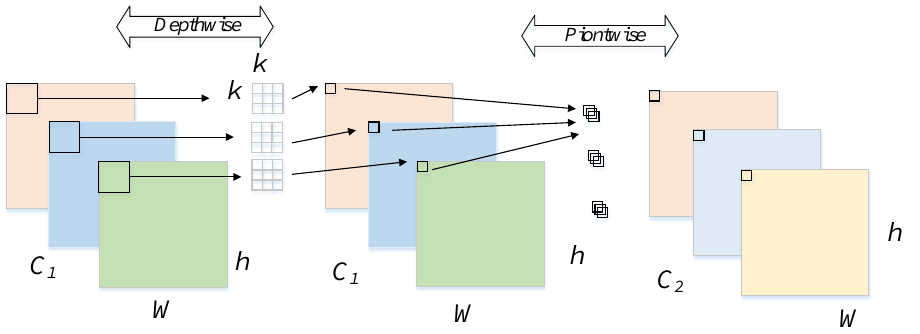
Figure 3. The process of Depthwise Separable Convolution.